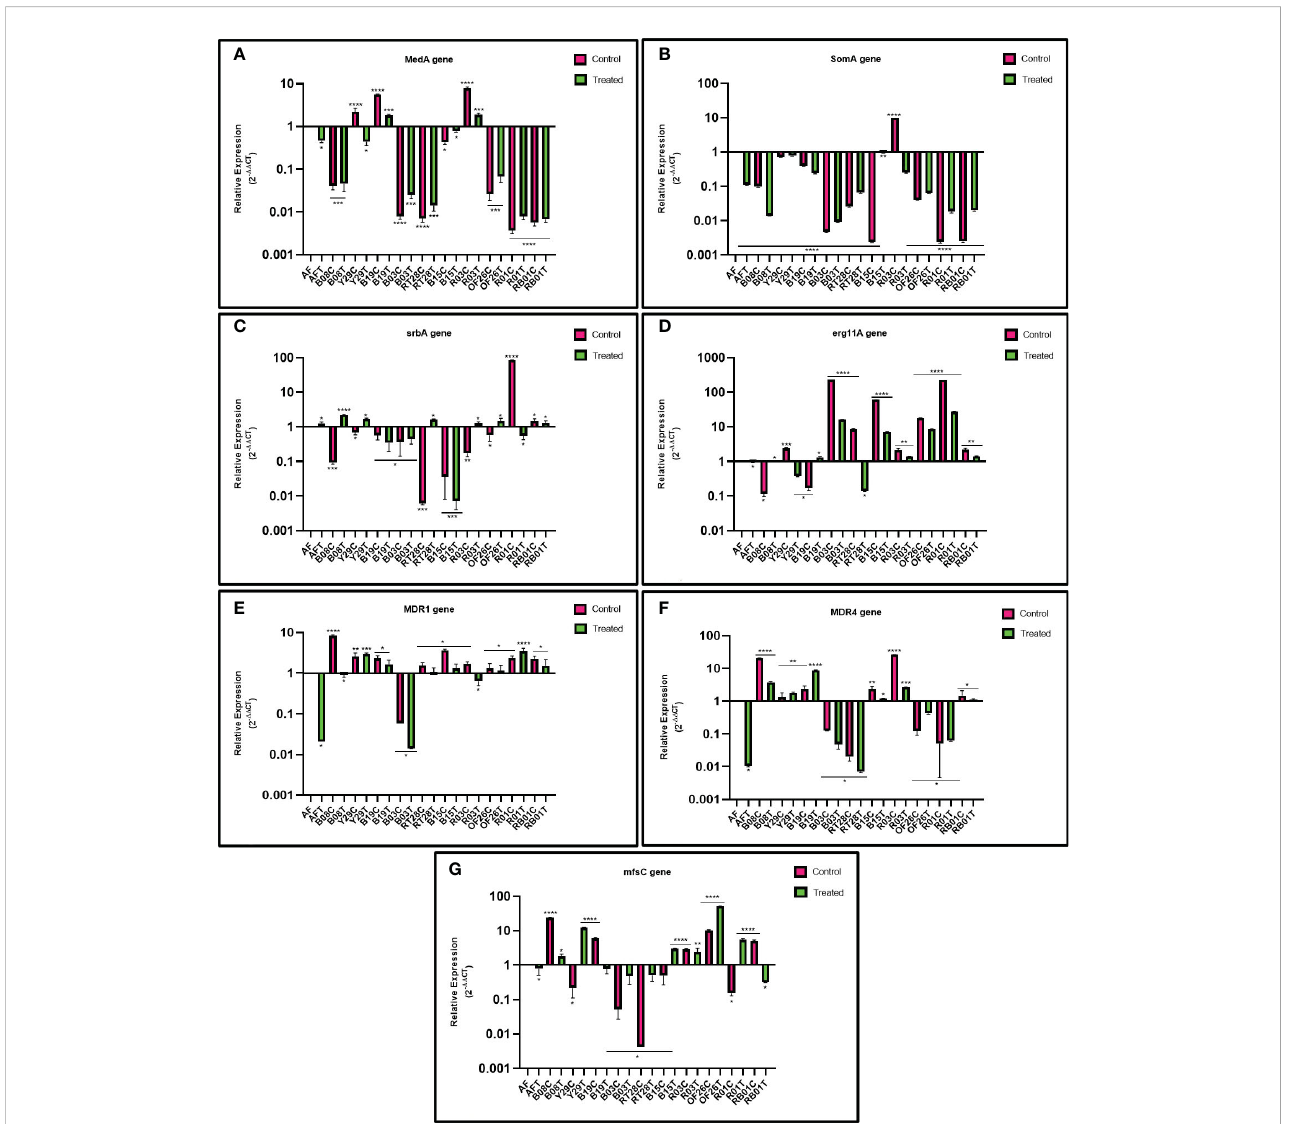
FIGURE 4 Relative expression of MedA (A) SomA (B) SrbA (C) erg11A (D) MDR1 (E) MDR4 (F) and mfsC (G) genes in azole-resistant environmental isolates relative to that in susceptible A fumigatus (wild type ATCC 46645) in untreated and eugenol-treated conditions. b -tubulin was used as a housekeeping gene to normalize transcription